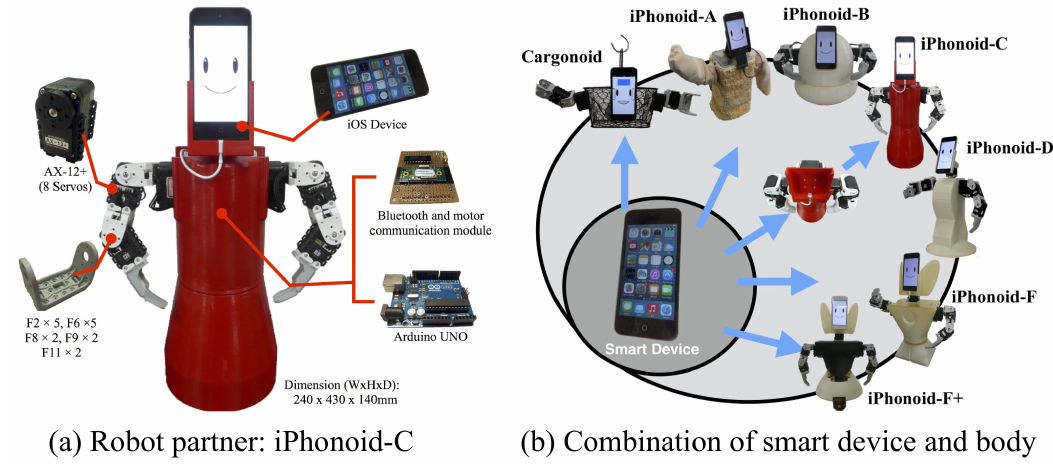
Figure 2. Development in various concepts using a 3D